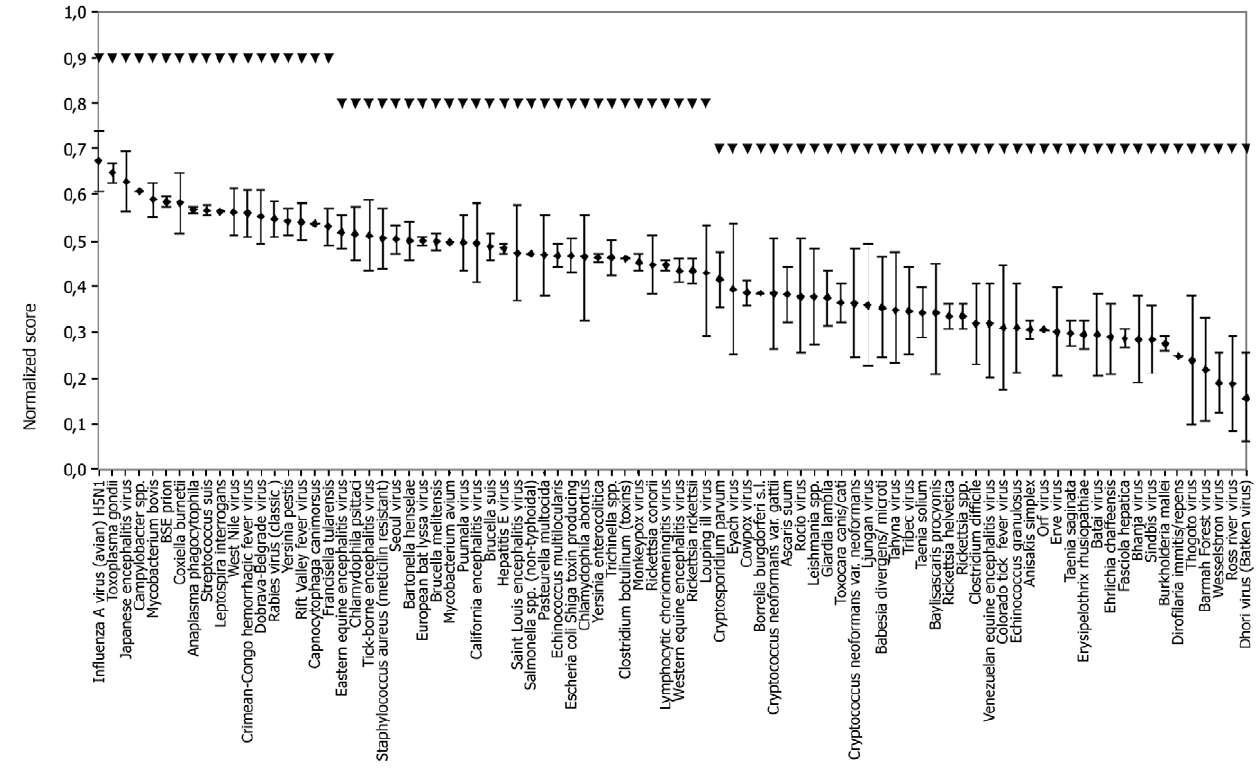
Figure 3. Emerging zoonotic pathogens relevant for the Netherlands (x-axis), prioritized according normalized scores (y-axis, means and 90% confidence intervals based on Monte Carlo simulation). Three groups of statistically different importance were identified by Classification and Regression Tree analysis and are represented by dashed lines. Mean (standard deviation) of the full dataset: 0.423 (0.124). Mean (standard deviation) of the three clusters: 0.577 (0.047); 0.476 (0.044); 0.317 (0.083).